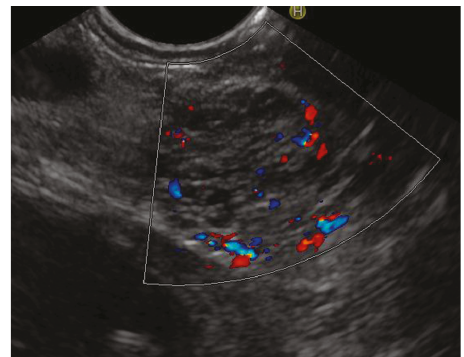
Figure 4: Serous cystic neoplasm with vascular septa.